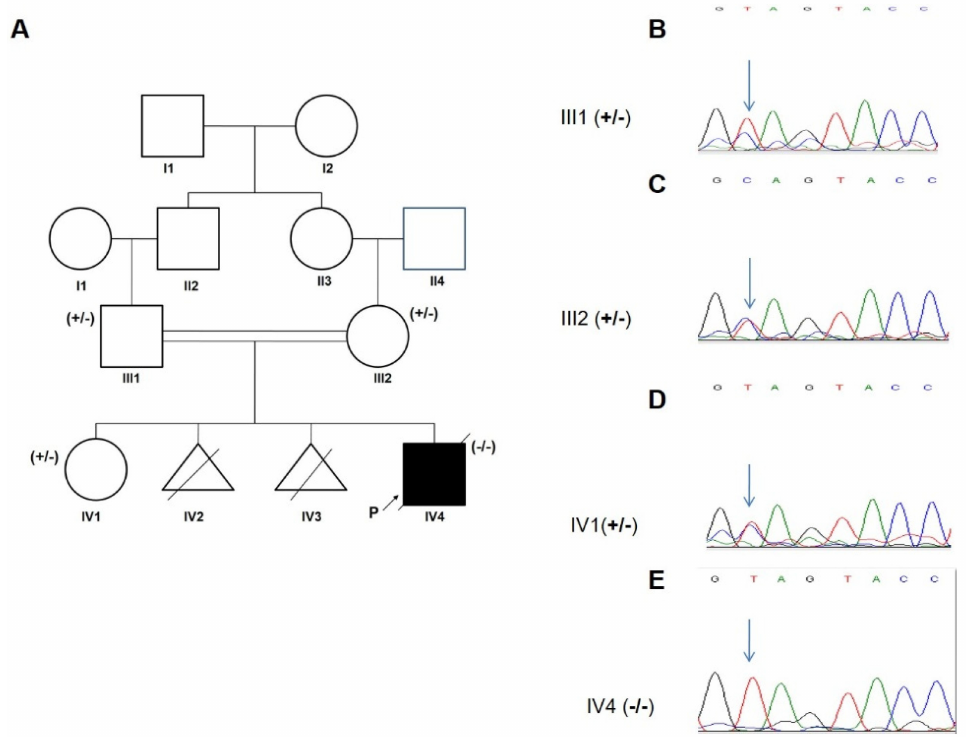
Figure 3. Family pedigree and segregation pattern. ( A ) Pedigree of the family; +/ − : heterozygous, − / − : homozygous. ( B – E ) Sanger sequencing chromatograms of the proband, his parents and healthy sister showing the TPP1 c. C832T variant indicated by an